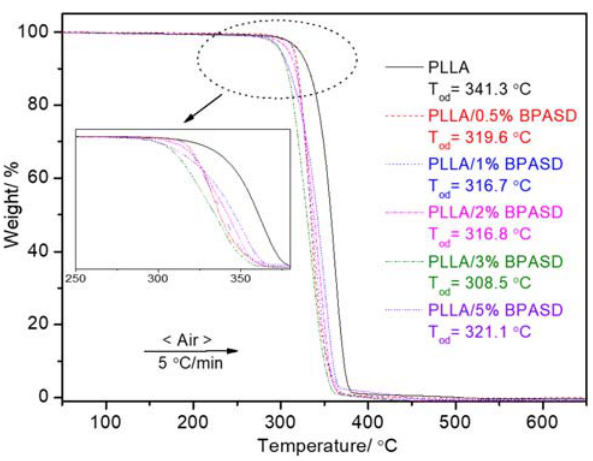
Figure 9: TGA curves of the virgin PLLA and PLLA/BPASD.